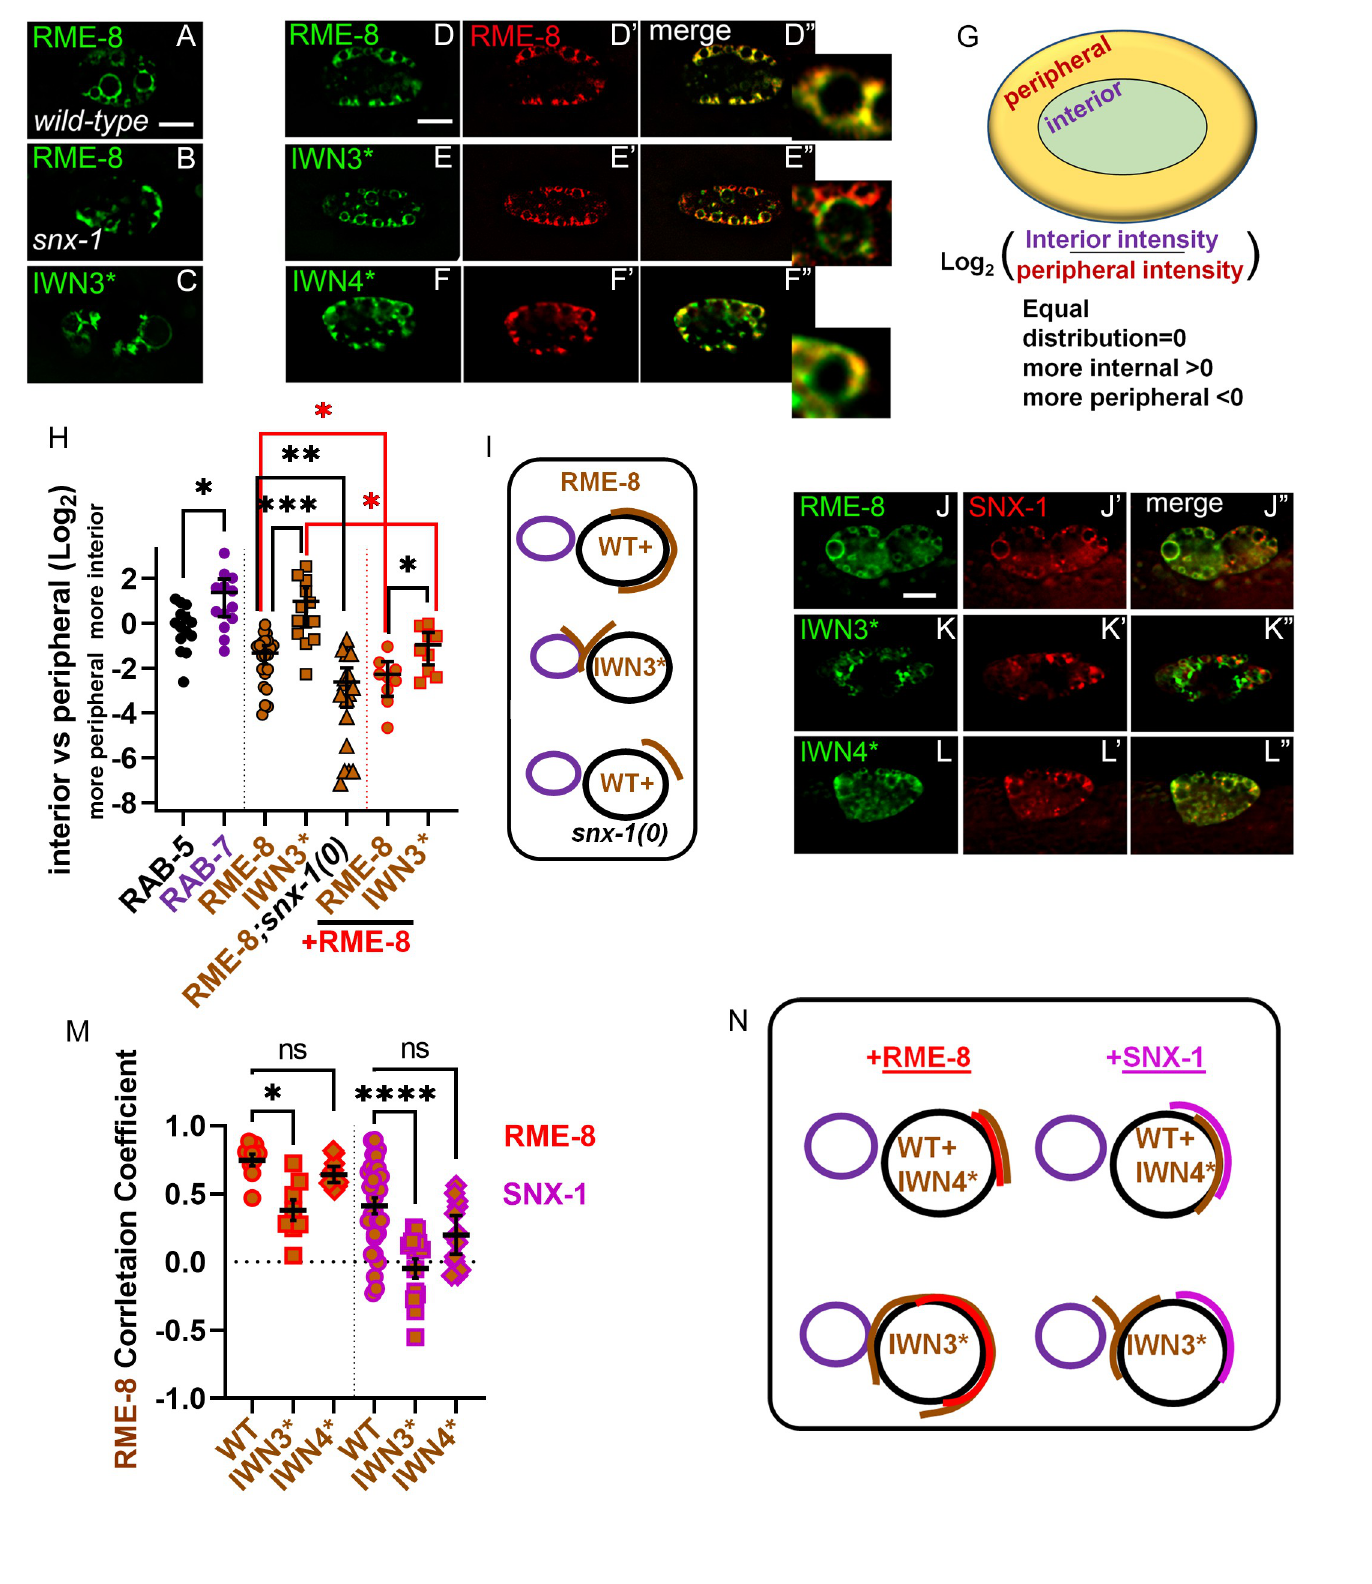
Fig 6. SNX-1, IWN3 � and RME-8 expression levels control RME-8 microdomain localization and positioning. (A-B) Micrograph of pCUP-4::GFP::RME-8+ wild-type (A) or (B) snx-1(0) mutant animals. (C) Micrograph of pCUP-4::GFP::RME-8 D1657K (IWN3 � ) in wild-type animals. (D-F”) Micrograph of TagRFP::RME-8